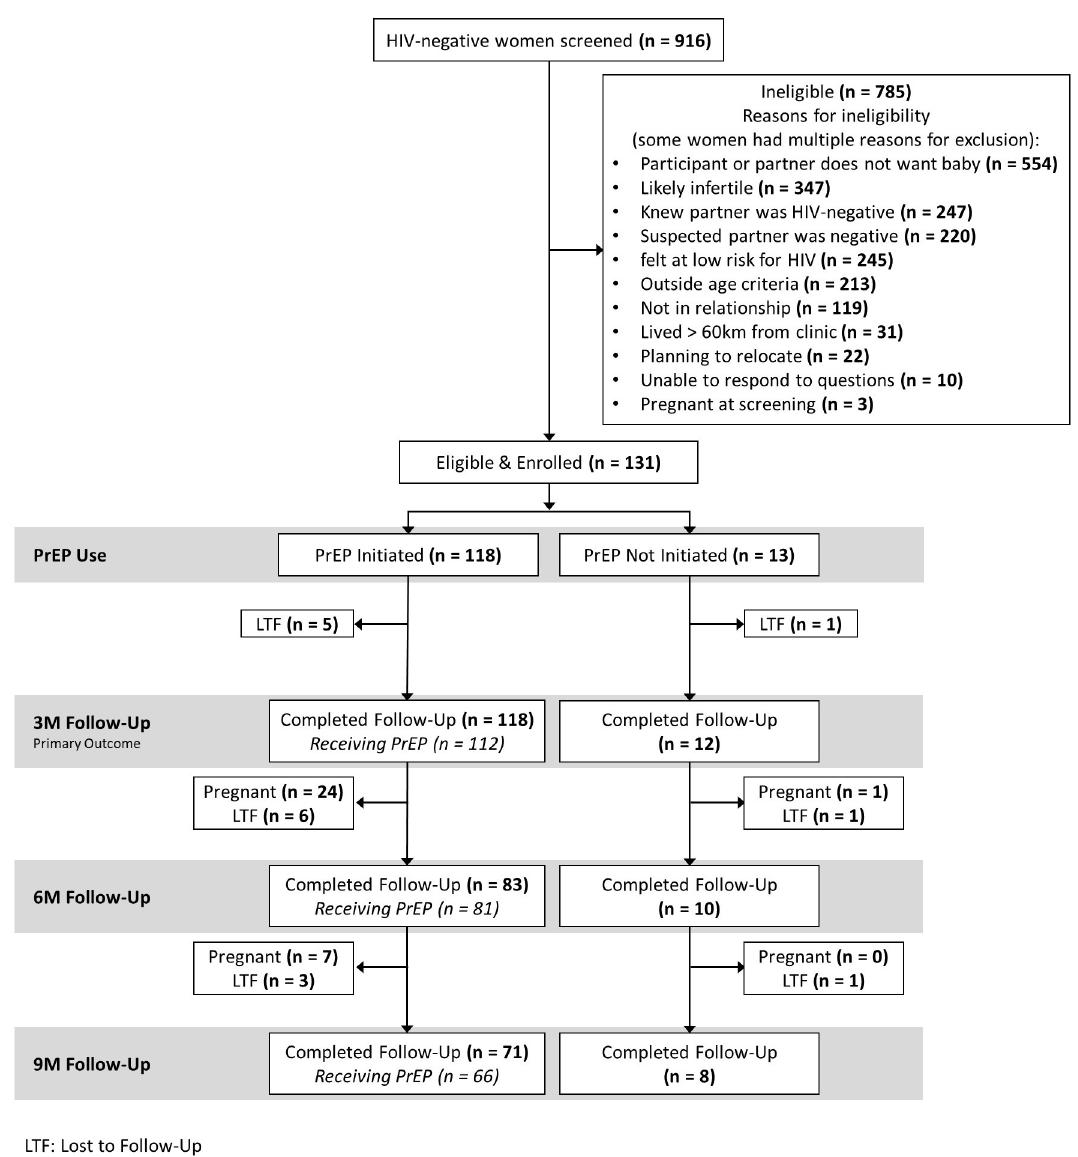
Fig 2. Summary of screening, eligibility, enrollment, PrEP uptake, and follow-up.